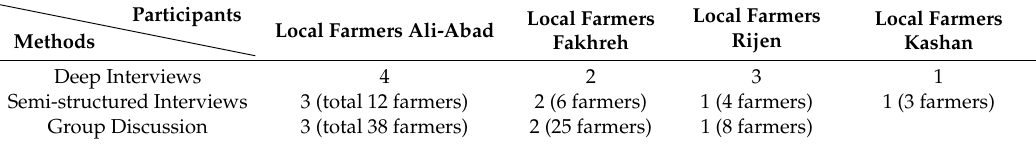
Table 3. Data collection in Kashan Villages (2011–2013) 1